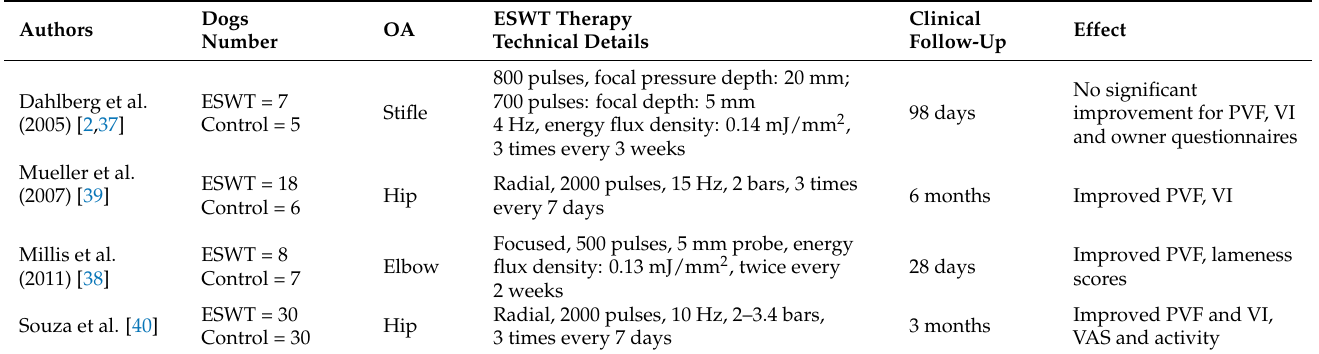
Table 2. Extracorporeal shockwave therapy (ESWT) for canine osteoarthritis (Abbreviations: PVF: peak vertical force; VI: vertical